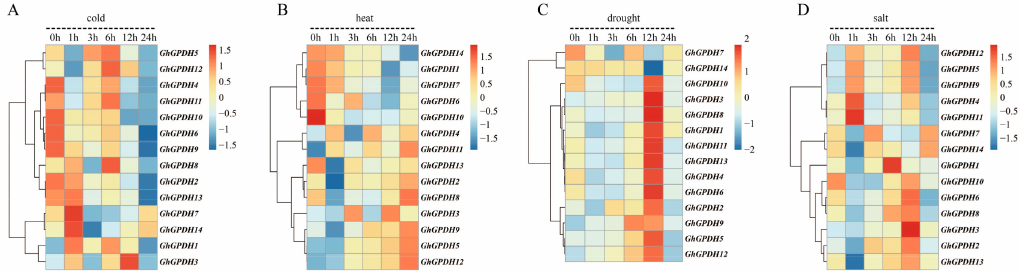
Figure 5. Transcription expression profiles of GPDH family genes in G. hirsutum under different stress treatment conditions. ( A – D ) are the transcriptional profiles of GPDH family genes under cold, heat, drought and salt stresses, respectively. Genes that were not expressed at all times were excluded.